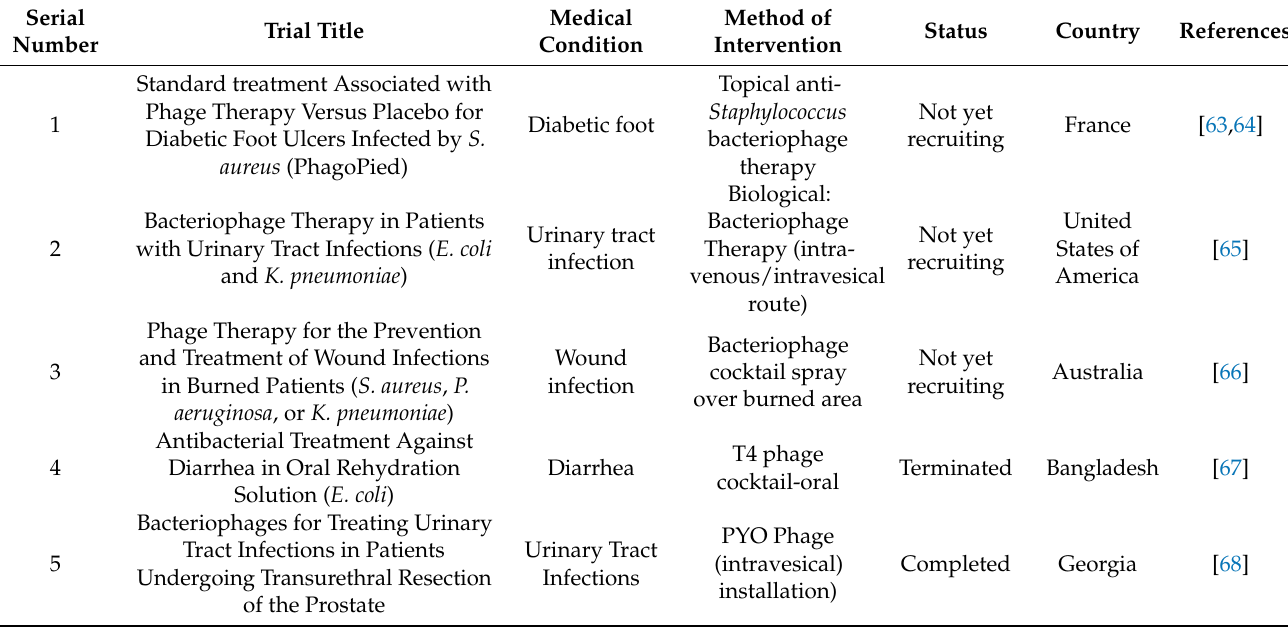
Table 2. Summary of the recent phage therapy clinical